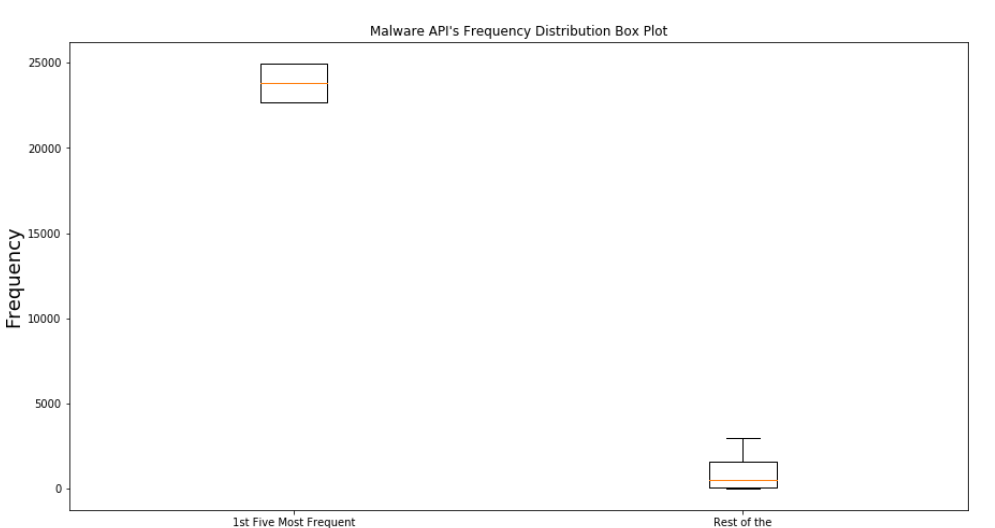
Figure 4. Box plot for malware API frequency